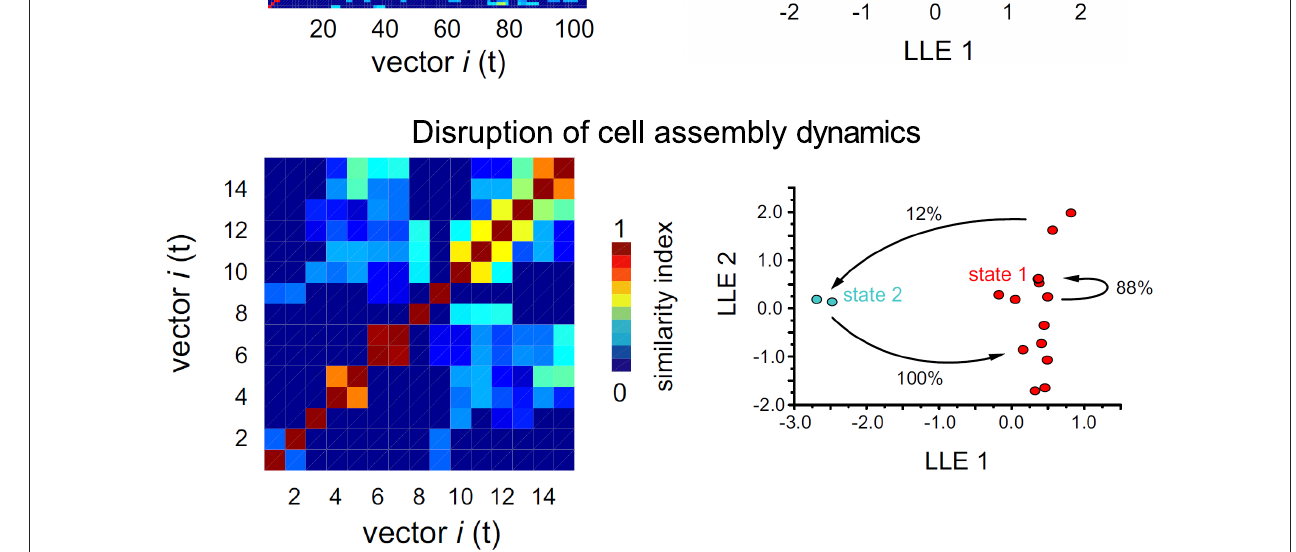
Figure 2 | Cell assembly dynamics in cortico-striatal slices. Left: maps showing the similarity index of the vectors representing network dynamics as a function of time. The vectors are generated from the firing of individual cells over time, each cell vector is compared with every other to generate the similarity index plot. Patterned structures indicate groups of cells firing together at different times. Right: two dimensional projection using locally linear embedding (LLE) of the vectors defining the states of the network. Arrows indicate transitions between different states. Top: NMDA receptor activation produced synchronous, recurrent and alternating activity in